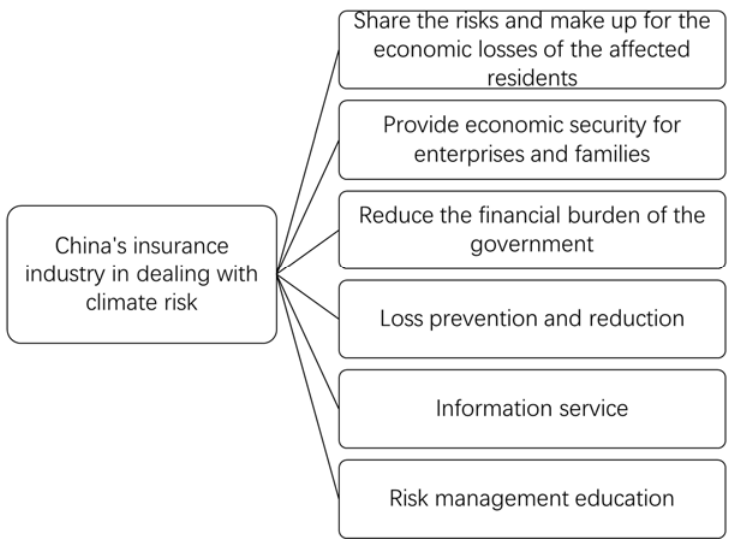
Figure 3. The role of China’s insurance industry in dealing with climate risk.